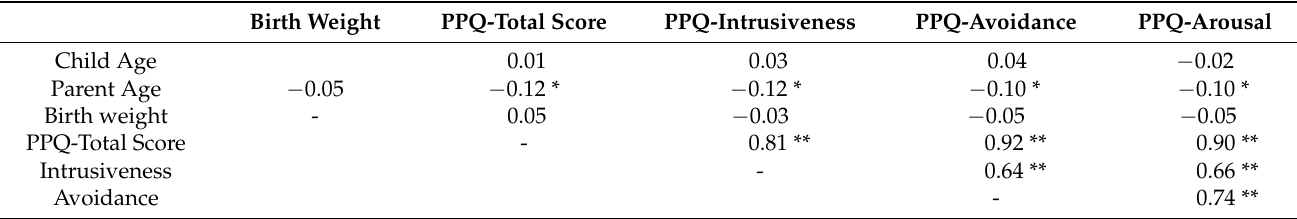
Table 5. Bivariate correlations between birth weight, parental age and all subscales of the Perinatal Post-Traumatic Stress Disorder Questionnaire (PPQ).